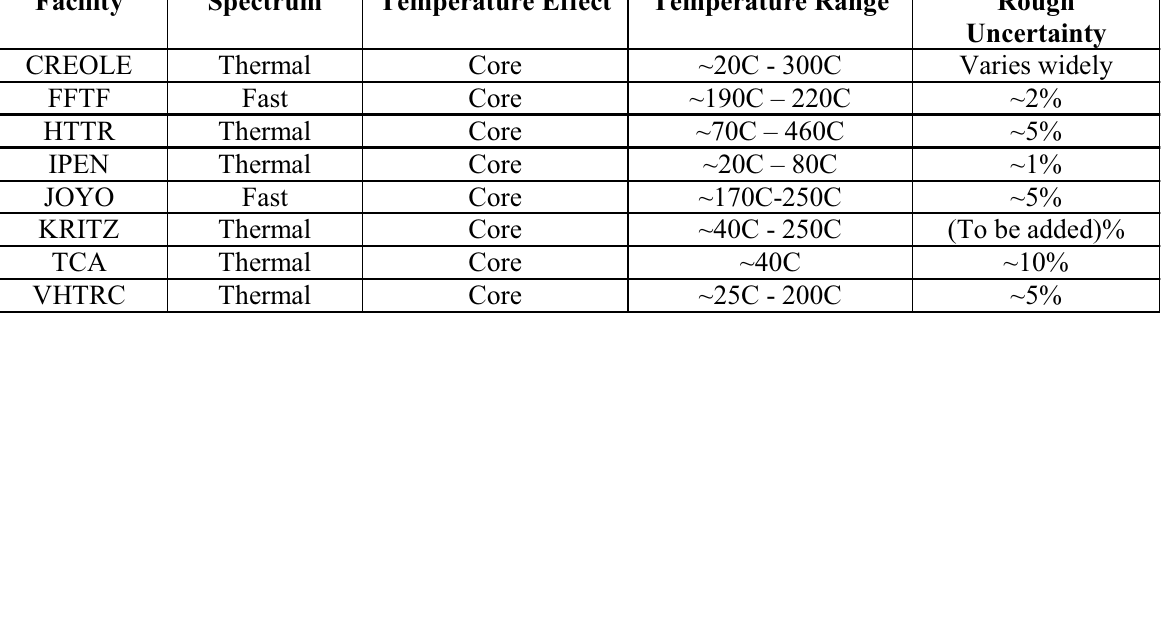
Table III.: Temperature reactivity experimental benchmarks in the IRPhEP Handbook